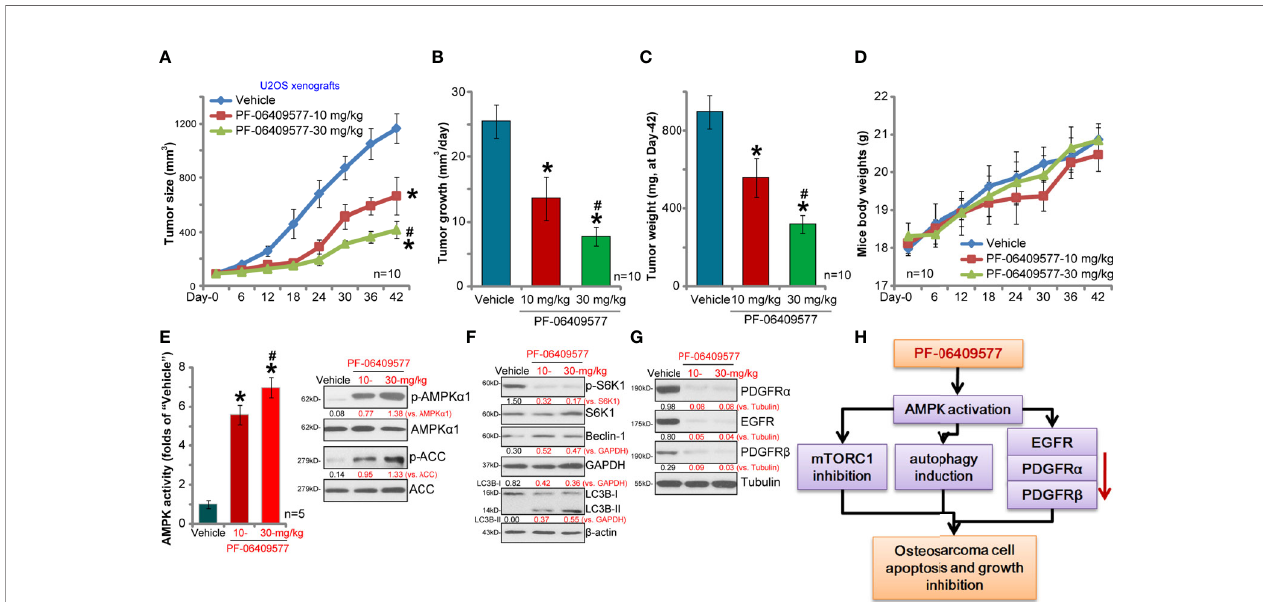
FIGURE 5 | PF-06409577 oral administration inhibits U2OS xenograft tumor growth in SCID mice. The U2OS xenograft tumor-bearing SCID mice (10 mice per group) were administrated with vehicle control ( “ Vehicle ” , saline) or PF-06409577 (10/30 mg/kg, oral gavage, daily for 24 days), tumor volumes (A) and mice body weights (D) were measured at every 6 days for a total of 42 days. The estimated daily tumor growth, in mm 3 per day, was calculated as described (B) . At Day-42, tumors of all three groups were weighted individually (C) . At Day-6, one xenograft USO2 tumor per group was recovered, after which each tumor was cut into fi ve random pieces (n = 5), and expression of the listed proteins was assessed by Western blotting analyses (F, G) , with relative AMPK activity tested as well (E) . The proposed signaling cascade of this study is shown (H) . Blot data were quanti fi ed and normalized to each loading control. Data were presented as mean ± standard deviation (SD). * p < 0.05 vs. “ Vehicle ” (A – C , F) . # p < 0.05 vs. PF-06409577 at 10 mg/kg (A – C , E) .